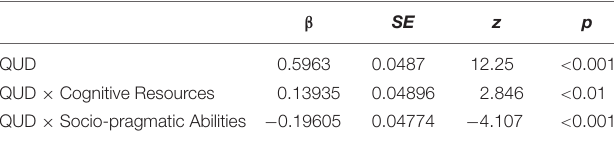
TABLE 1 | Summary of the final model analyzing N = 64 participants’ ratings as a function of QUD and individual difference